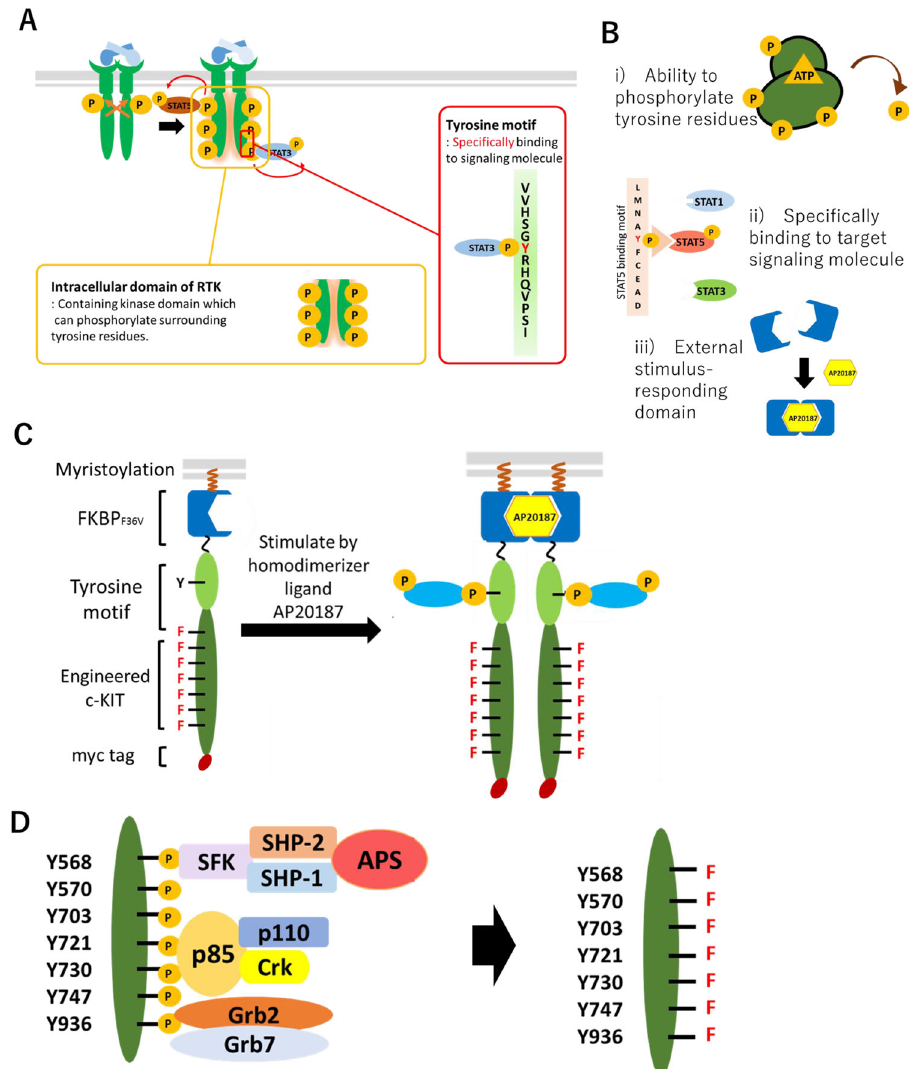
Fig. 1 Schematic illustration of designer receptors. A Ligand binding to the receptor tyrosine kinase (RTK) leads to activation of the intracellular kinase domain. The intracellular domain of c-KIT is engineered in this study. A tyrosine motif is a short sequence which is derived from another receptor. B The designer receptors in this study consist of 3 parts; (i) an engineered tyrosine kinase which has an ability to phosphorylate the tyrosine motif, (ii) a tyrosine motif, which speci fi cally binds to a target signaling molecule when phosphorylated, and (iii) an external stimulus-responding dimerizing domain (e.g., AP20187-responsive FKBP F36V ). C Illustration of the activation process of the designer receptor. FKBP F36V , a tyrosine motif, and the engineered c-KIT are linked together to create a designer receptor. The designer receptor dimerizes when stimulated by AP20187. D The kinase domain of wild-type c-KIT functions as a scaffold domain which recruits many intracellular signaling molecules. To obtain the domain which functions only as a kinase, the 7 tyrosine residues which are known as a scaffold for recruiting signaling molecules are mutated to